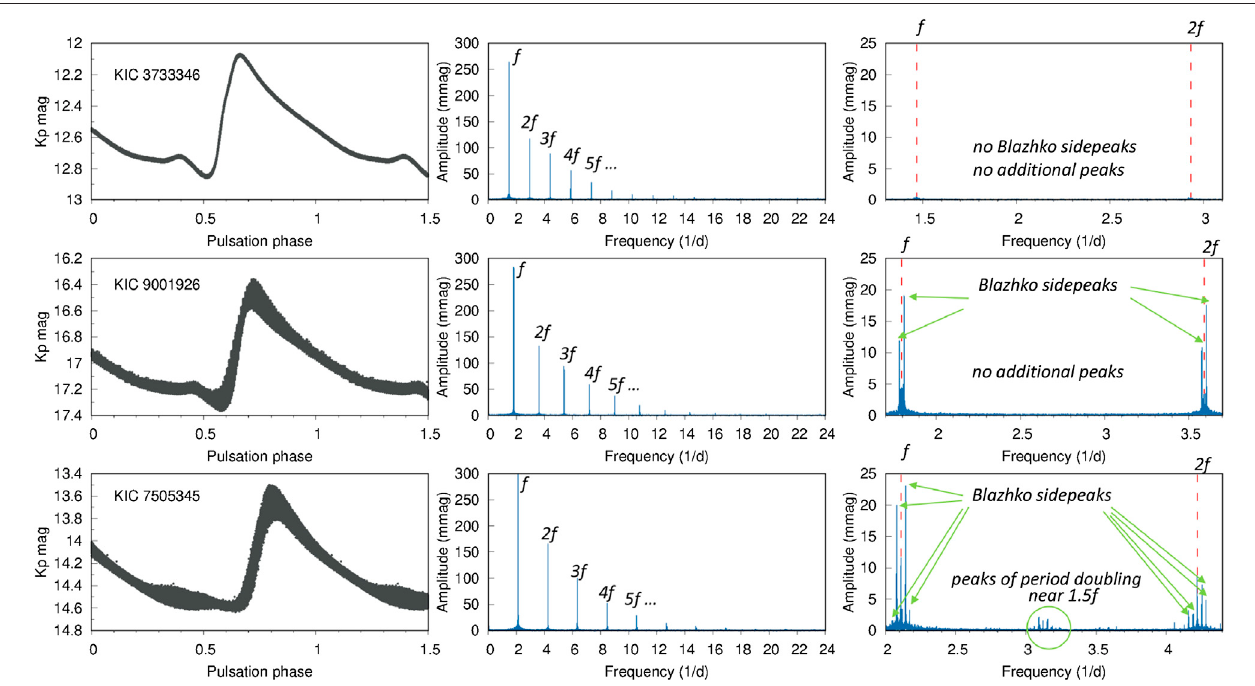
FIGURE 1 | Examples of non-Blazhko, Blazhko, and period doubled Blazhko RRab stars of the Kepler fi eld. Panels show folded light curves, Fourier spectra, and zooms of residual spectra (after prewhitening with the pulsation frequency series: f , 2 f , 3 f ... ), respectively. Based on the light curves published by Benk ő et al. (2014).